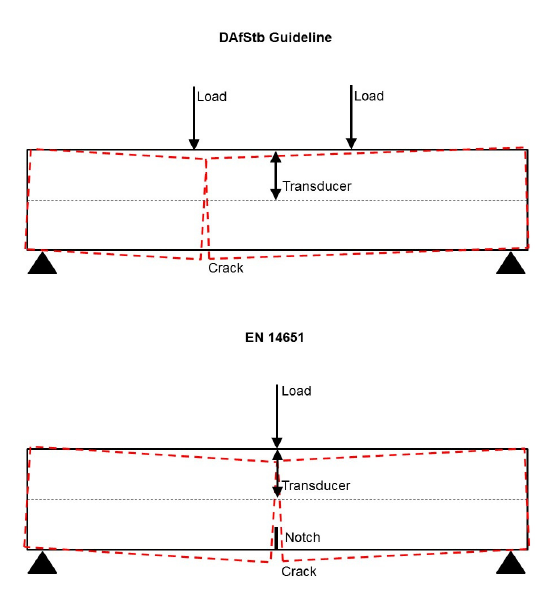
Figure 1. Comparison of test set-ups